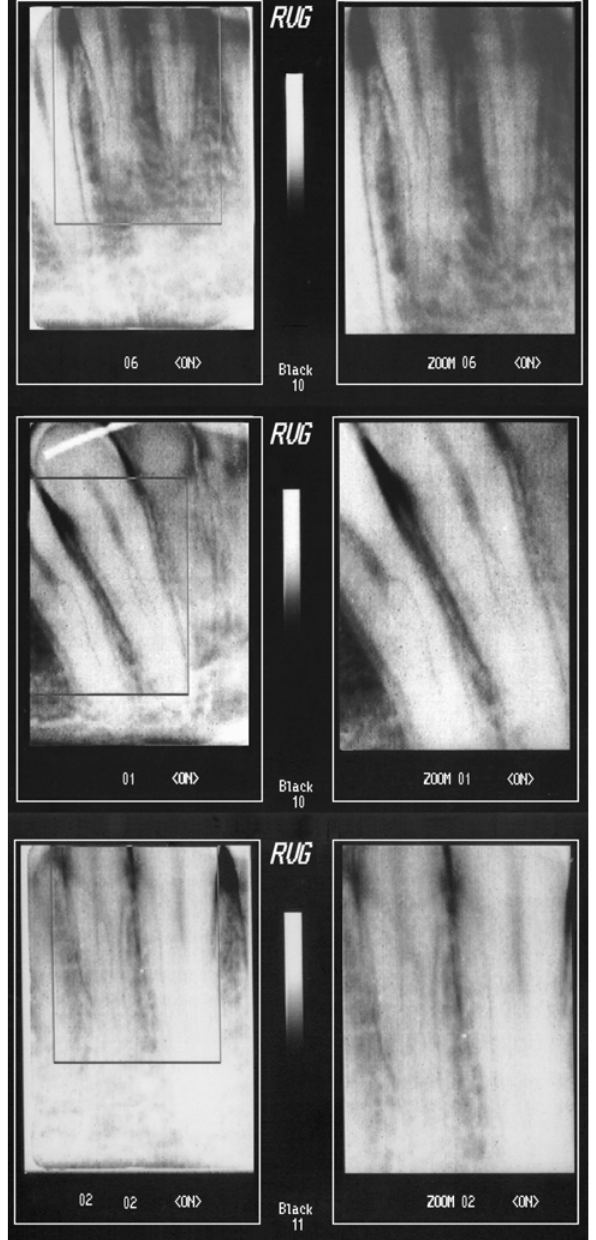
FIGURE 4- Images of root canal bifurcation in the in vivo study and magnification on the right side of the